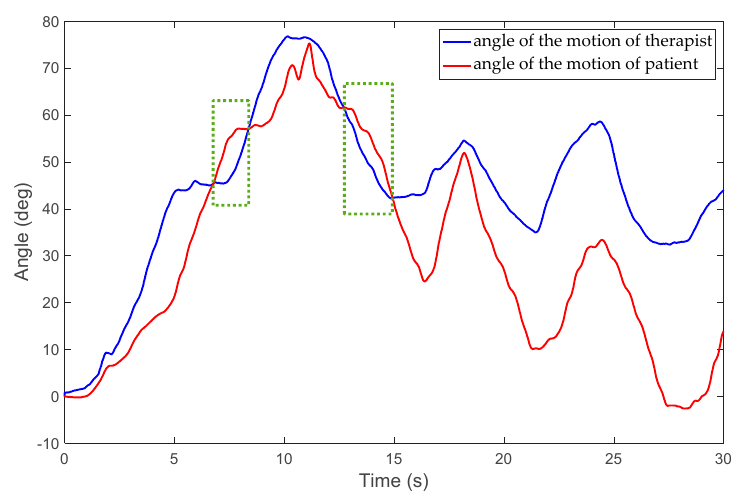
Figure 11. Position of the green object and target object in the visual model.